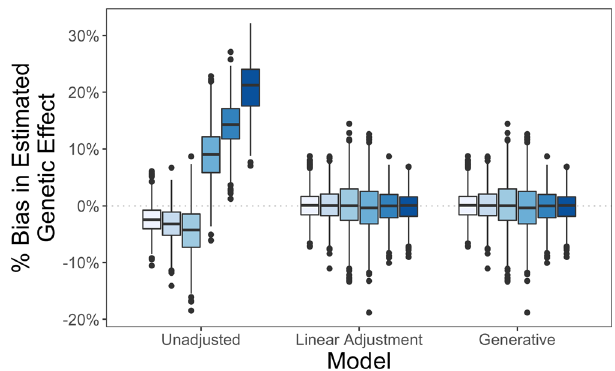
Fig. 4 Adjusting for covariates provided to DeepNull during association testing is necessary to avoid bias. The unadjusted model regresses y i on (cid:1) g i and h ( x i ), the prediction of y i based on x i , omitting x i from the association model. This approach results in biased estimation of the genetic effect. The linear adjustment model regresses y i on (cid:1) g i , x i , and h ( x i ). This approach is unbiased. The generative model regresses y i on (cid:1) g i , x i , and x 2 represents the best possible performance. Each box plot summarizes results from n = 10 3 independent simulation replicates. The box demarcates, from top to bottom, the 75th, 50th, and 25th percentiles of the corresponding distribution. The whiskers extend between the largest and smallest values within 1.5 times the interquartile range. Any values outside the whiskers are marked by points. Source data are provided as a Source Data fi